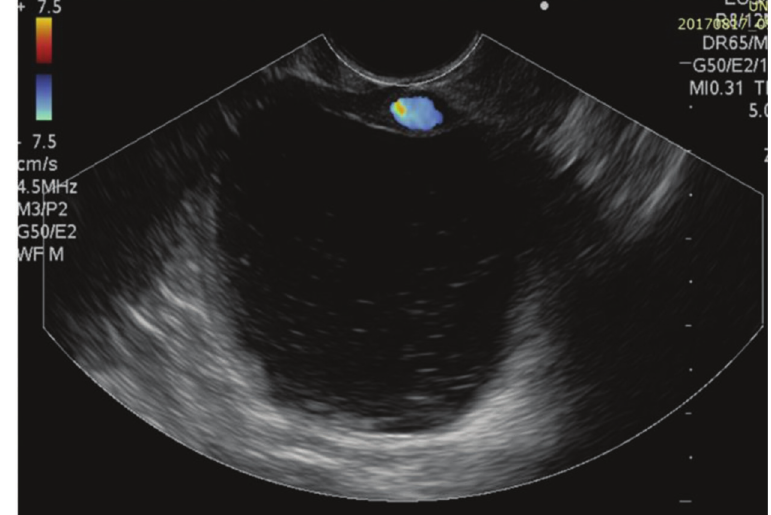
Figure 1 - Identification of pancreatic pseudocysts on an endoscopic ultrasound image Doppler ultrasound was used to assess the gastric or duodenal wall for interposed vessels.